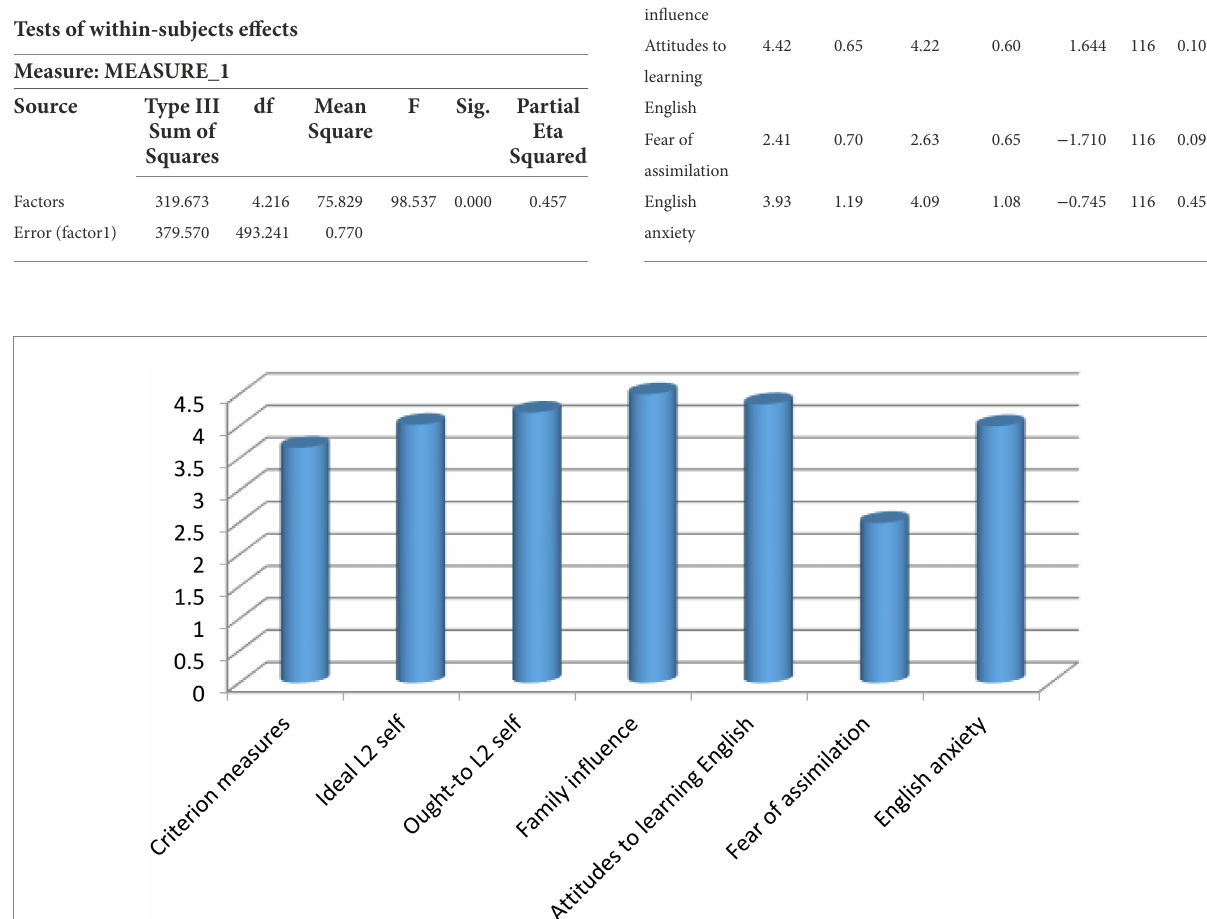
TABLE 3 Comparison of students’ responses to all scales of the questionnaire.